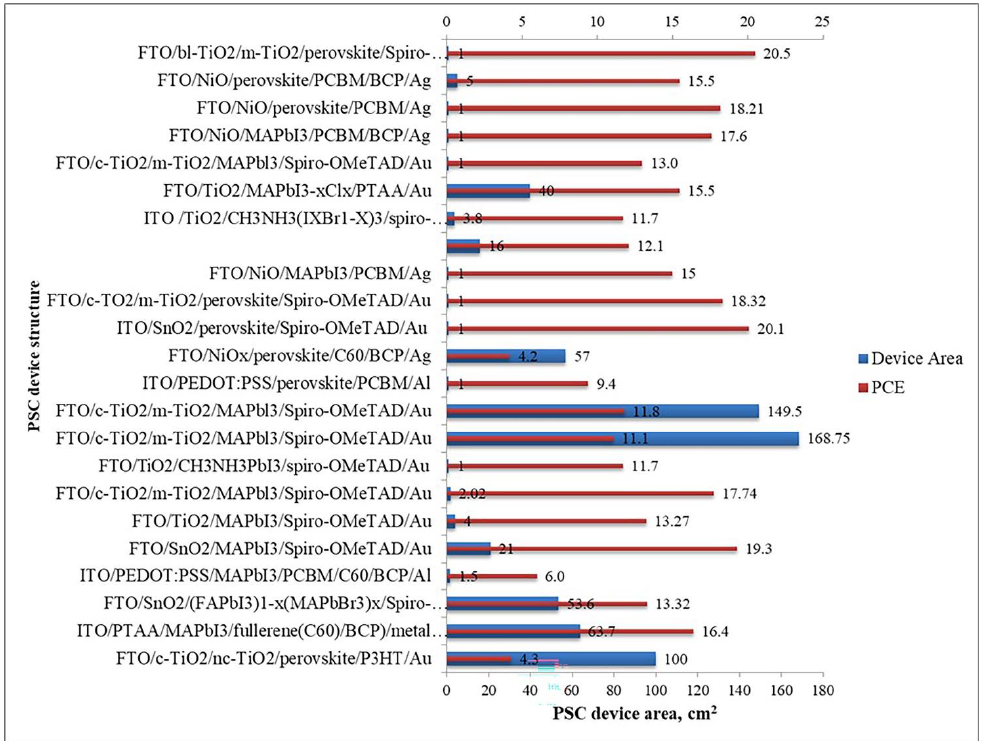
Figure 19. Comparison of published successful large-area PSC device structures, PCE values, and device areas (all ≥1 cm 2 ) discussed in this current work.